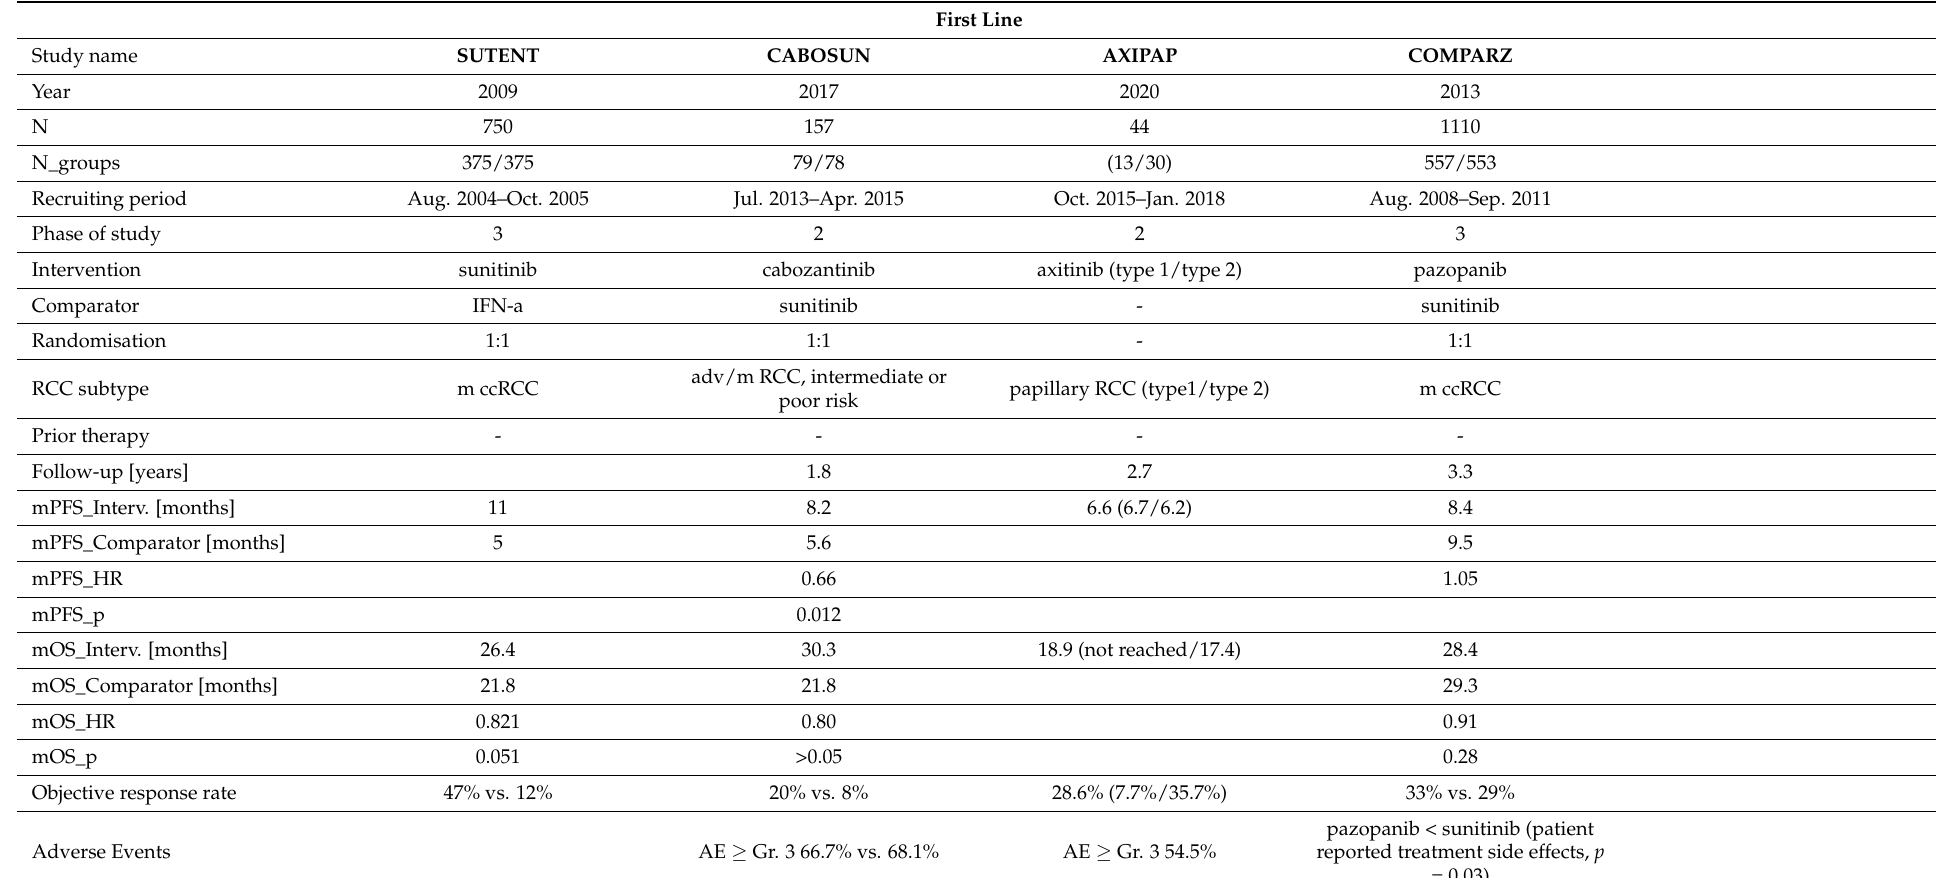
Table 1. List of all relevant clinical studies on TKI monotherapy for mRCC with reported treatment efficacy and safety